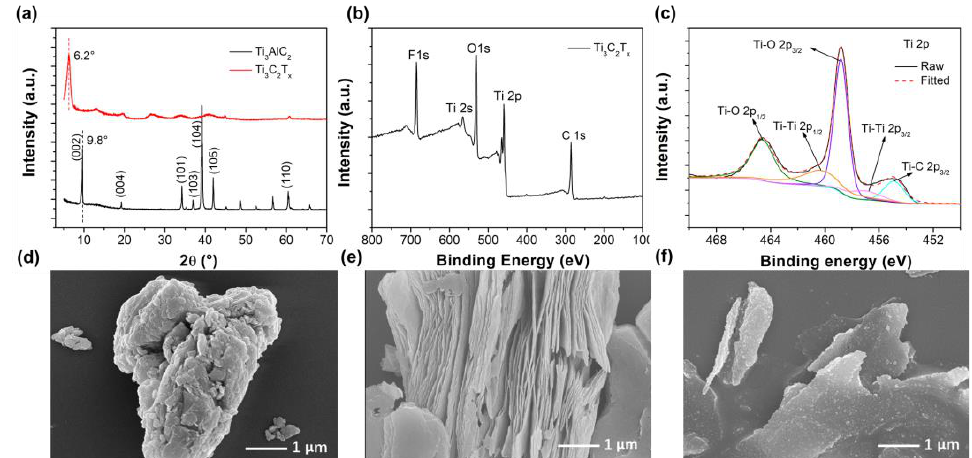
Figure 1. ( a ) X-ray diffraction (XRD) patterns of Ti 3 AlC 2 and Ti 3 C 2 T x ; ( b ) X-ray photoelectron spectroscopy (XPS) spectrum and ( c ) deconvoluted high-resolution XPS spectra of Ti 2p for the prepared fewer layer Ti 3 C 2 T x . Scanning electron microscope (SEM) images of ( d ) Ti 3 AlC 2 ; ( e ) primary Ti 3 C 2 T x and ( f ) fewer layer Ti 3 C 2 T x .